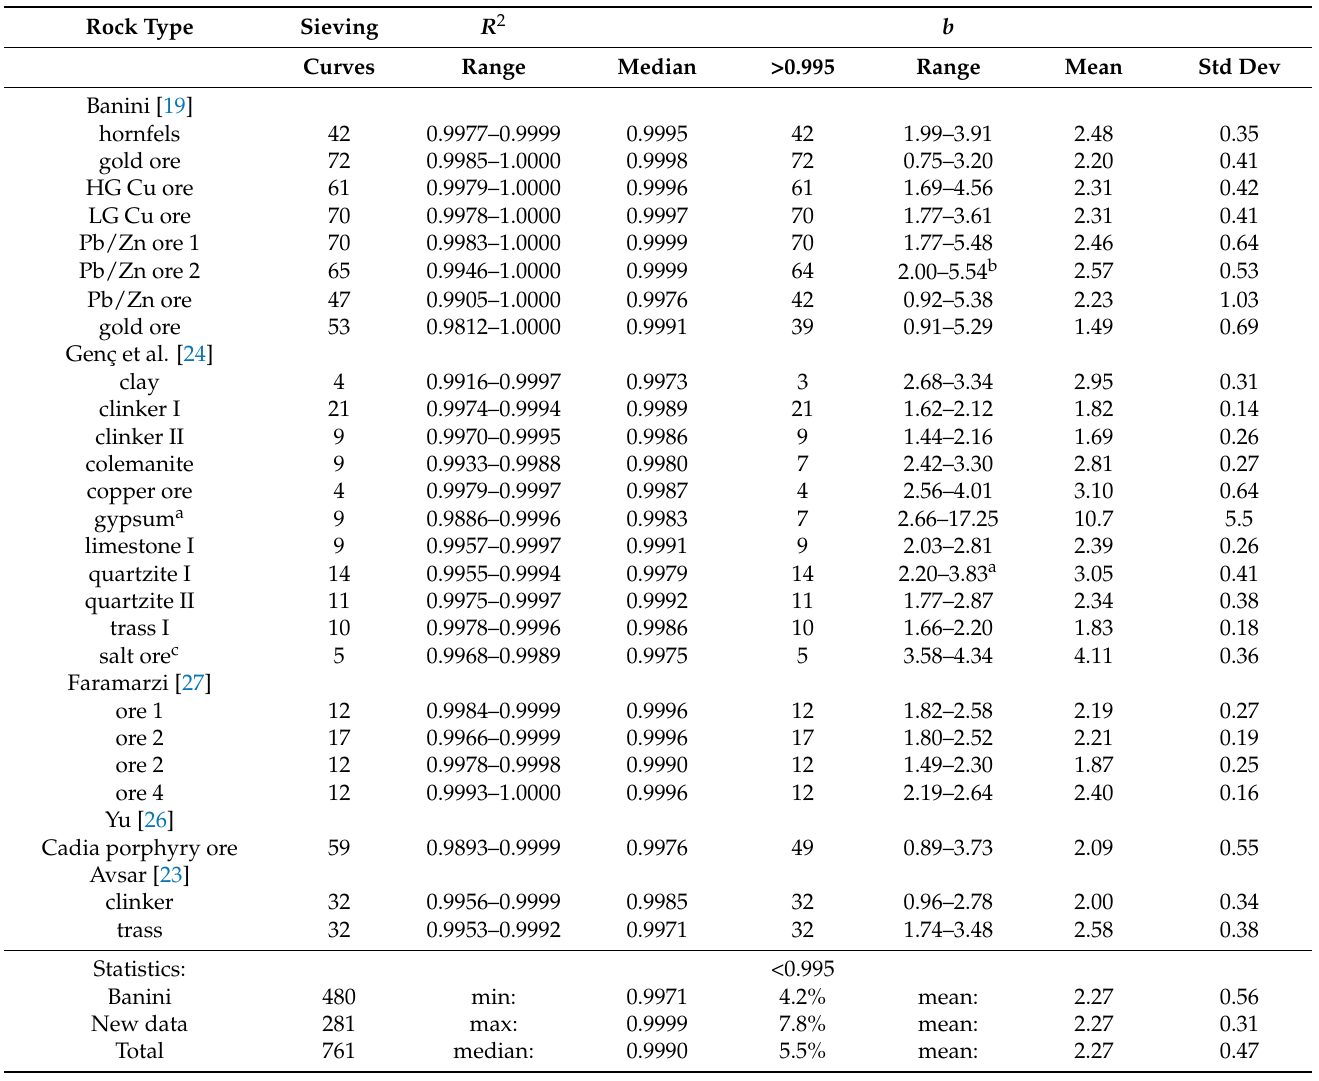
Table 3. Results of fitting Swebrec function to sieving